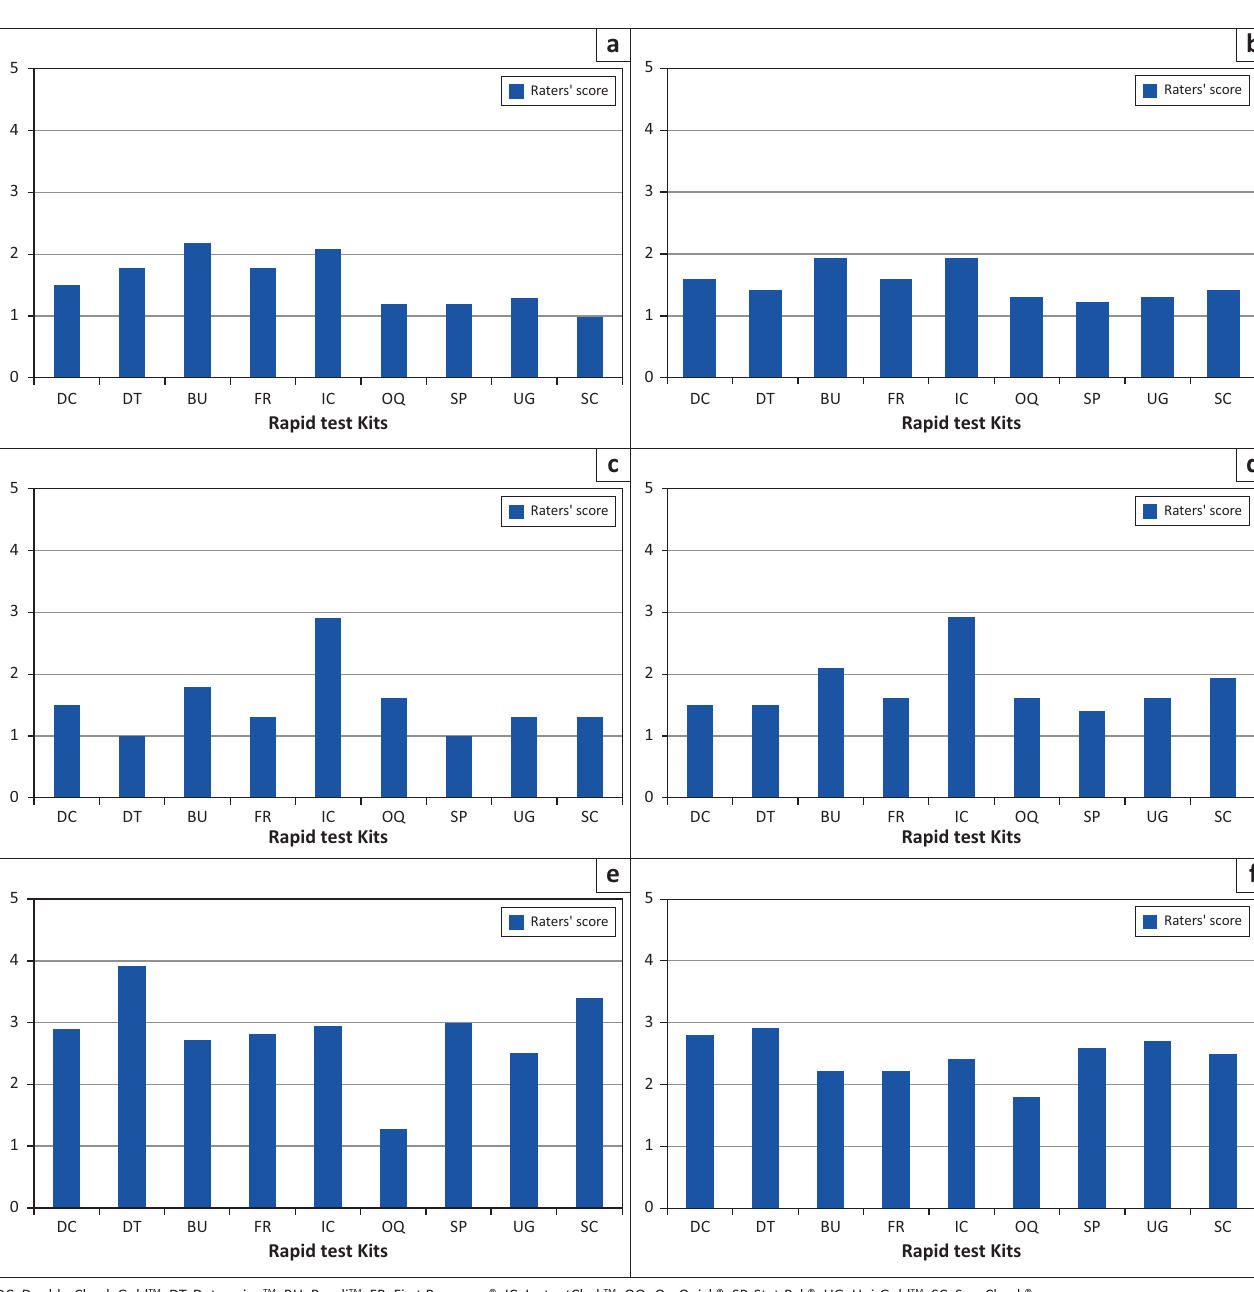
FIGURE 2: Results from questionnaires administered to laboratorians conducting the evaluation. Respondents were asked to rate all nine kits based on the following criteria: ease of reading the reaction line (panel a); ease of interpreting the test results (panel b); ease of learning how to perform the test (panel c); and overall ease of using and running the kit (panel d). Scores ranged from very easy (1) to very difficult (5) for this set of four questions; panels a–d represent average scores. Respondents were also asked about the size of the packaging (panel e), with scores ranging from 1 (very bulky) to 5 (very compact); and about quantity of waste generated (panel f), with scores ranging from 1 (a lot of waste) to 5 (minimal waste). Panels e-f represent average